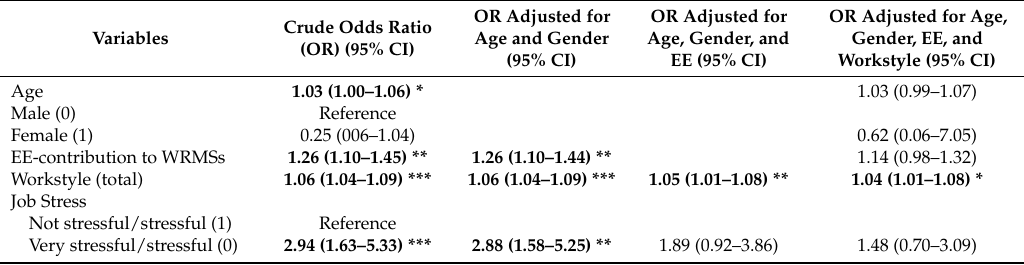
Table 4. Demographic, ergonomic exposure (EE), workstyle, and job stress associated with WRMSs in NAs working in nursing homes: Results from multivariable logistic regression with incremental adjustment for potential confounders (N =